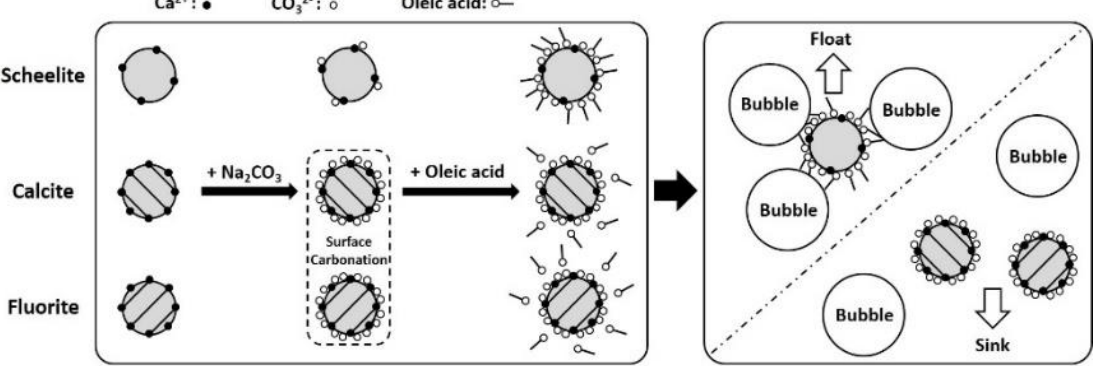
Figure 6. Schematic diagram of the selective depressing mechanism using sodium carbonate on the Ca-bearing mineral surface for recovery of scheelite .